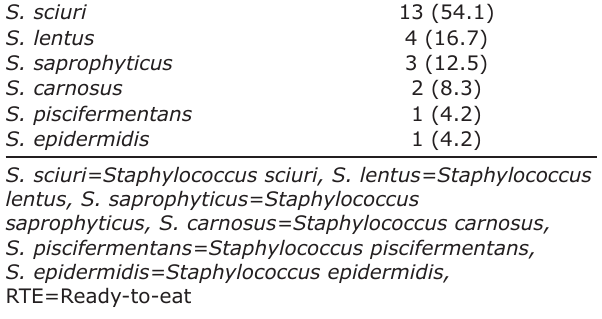
Table-3: Distribution of Staphylococcus species (n=24) isolated from RTE meats from Enugu State, Nigeria. Staphylococcus species identified